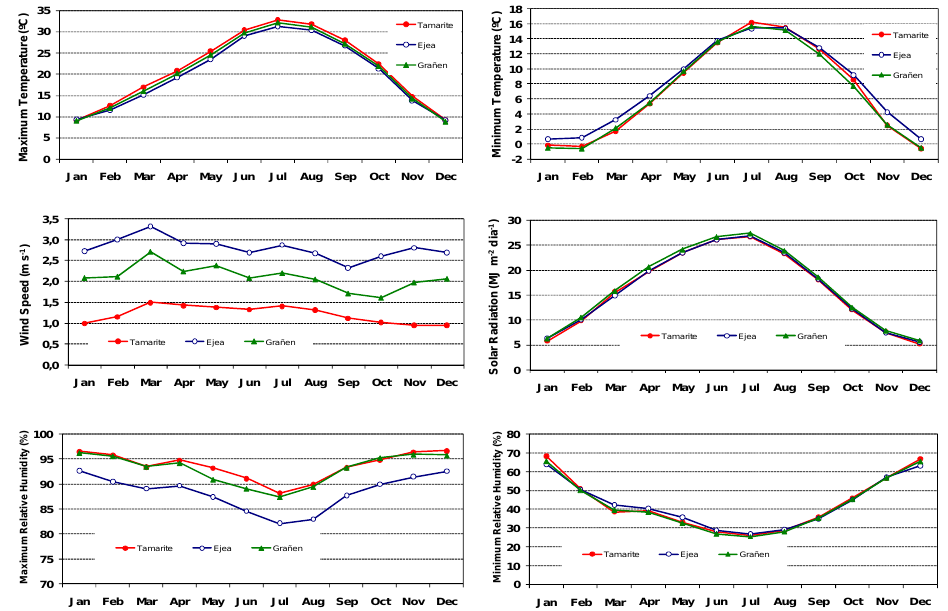
Fig. 2. Long-term monthly meteorological conditions during the period analyzed (2004-2011) in the Irrigation Districts of Riegos del Alto Aragón (weather station, Grañén), Canal de Bardenas (weather station, Ejea) and Canal de Aragón y Cataluña (weather station, Tamarite).